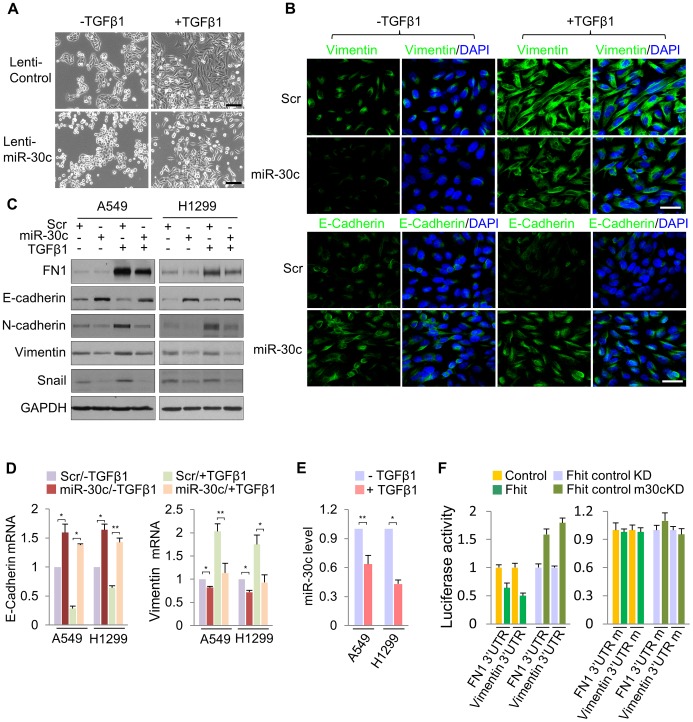
miR-30c inhibits TGF-β-induced EMT through direct targeting of Vimentin and Fibronectin.(A) Phase contrast images of A549/miR-30c cells in response to TGF-β1 treatment. Scale bar, 100 µm. (B), (C) Immunofluorescence images and Western blot analysis of EMT markers, E-cadherin, FN1 and Vimentin, in miR-30c-transfected A549 cells treated with TGF-β1, respectively. Scale bar, 20 µm. (D) RT-qPCR analysis showing induction of E-cadherin and a decline in the expression of Vimentin in TGF-β-induced A549/miR-30c cells. *P<0.05 and **P<0.01 by Student's t-test. (E) RT-qPCR for miR-30c in response to TGF-β1 treatment. *P<0.001 by Student's t-test. (F) miR-30c down-regulates mesenchymal markers, Vimentin and Fibronectin by directly targeting their 3′ UTRs. Luciferase reporters assays using wild type or mutant 3′ UTR were performed after transfection into A549/FHIT or A549/FHIT cells with miR-30c knockdown. Experiments were performed three times and the data are presented as the mean ± s.d.